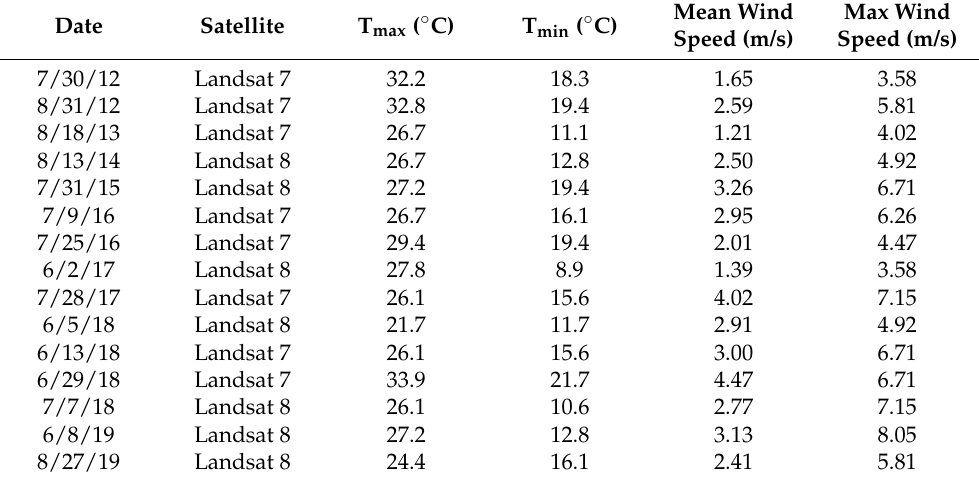
Table 1. Dates, satellite, daily high and low air temperatures, and daily mean and maximum wind speed for the 15 scenes analyzed. Daily temperature data and wind speed were recorded at the Dane County Regional Airport and accessed through the Midwestern Regional Climate Center’s online data